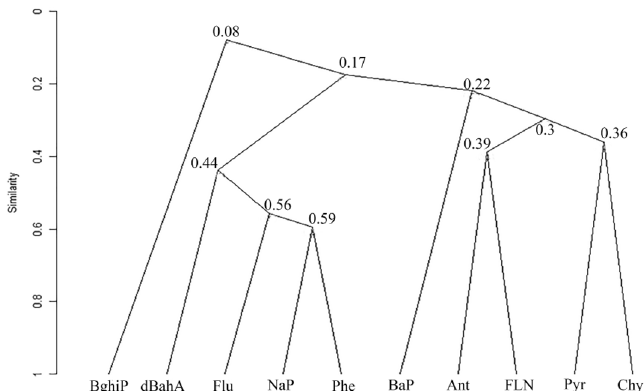
Figure 8. Hierarchical dendrogram of the objects similarity by the Sørensen